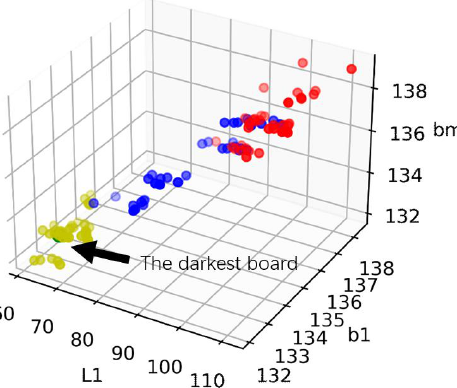
Figure 3. Scatter distribution of three kinds of solid wood floors in color space.